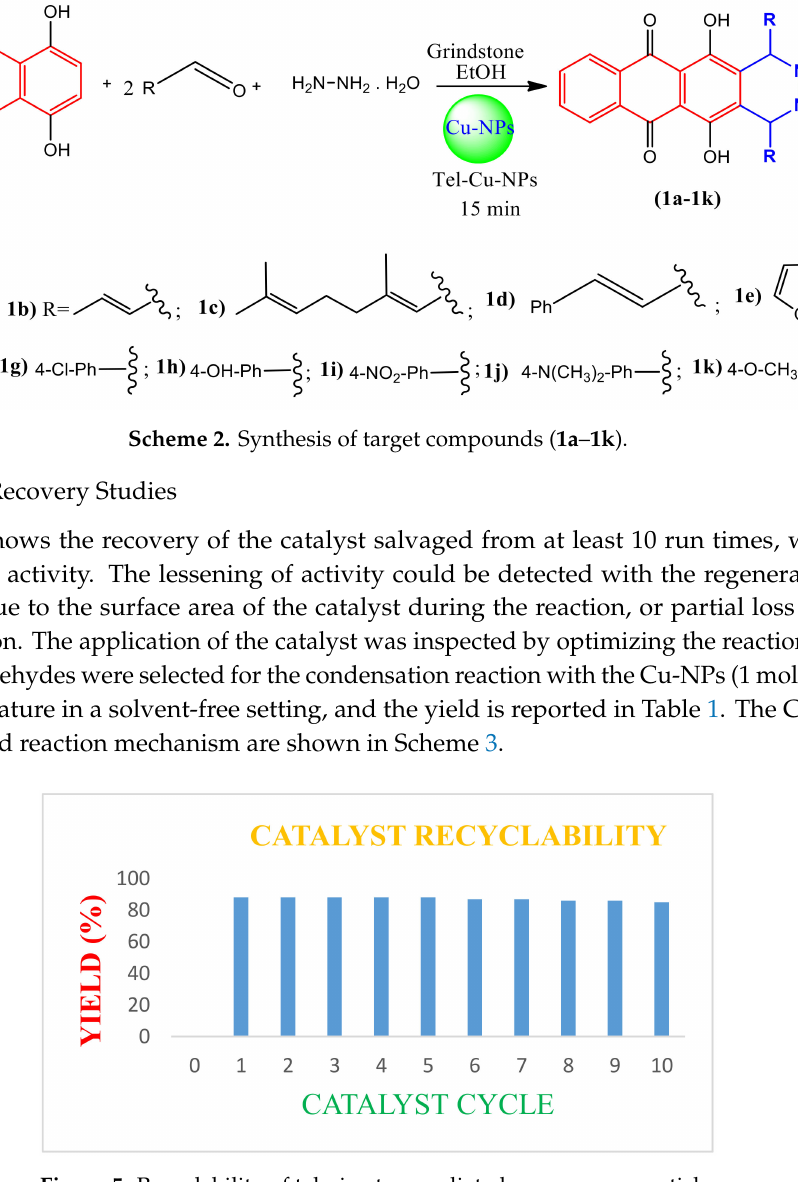
Figure 5. Recyclability of telmisartan mediated copper nanoparticle. Table 1. Catalyst